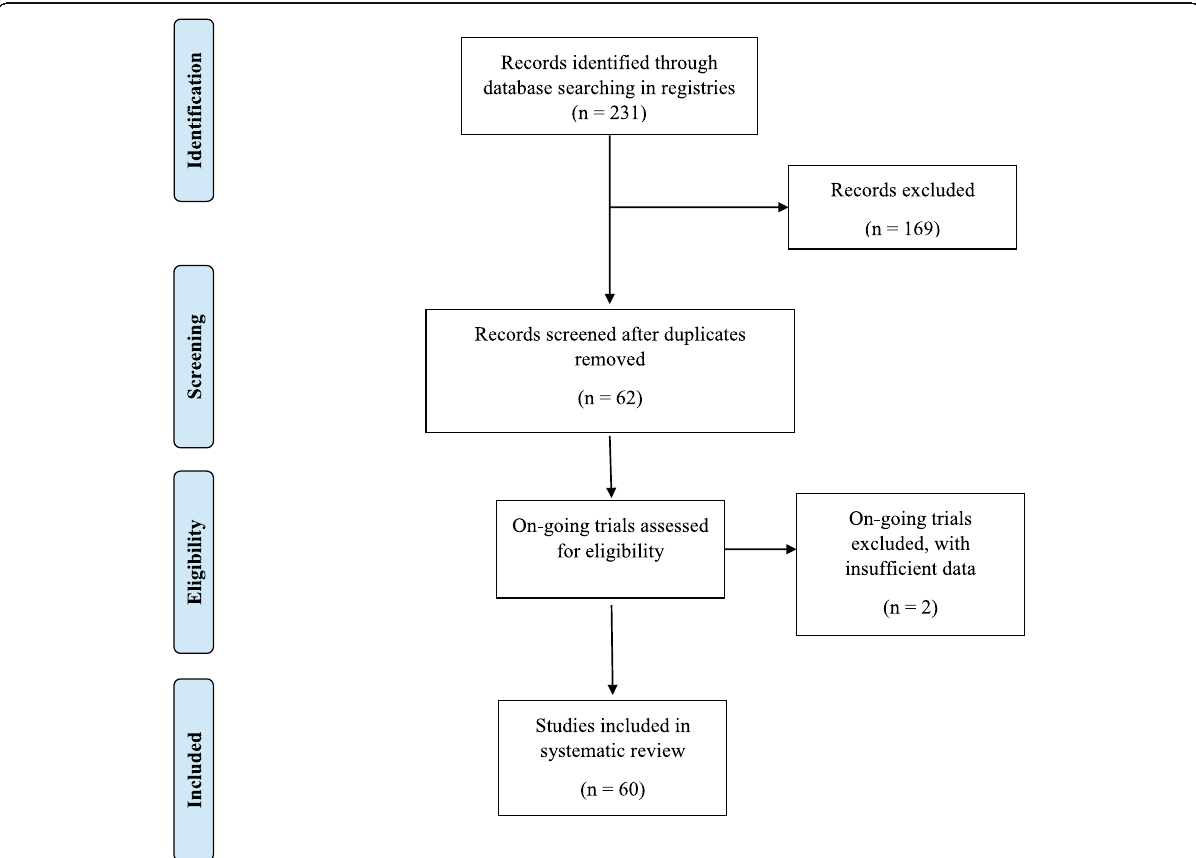
Fig. 2 PRISMA flow diagram of reporting search